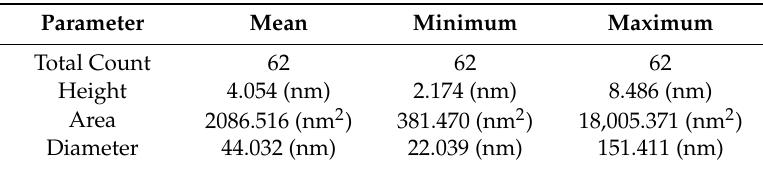
Table 9. Analysis of the atomic force microscopy of